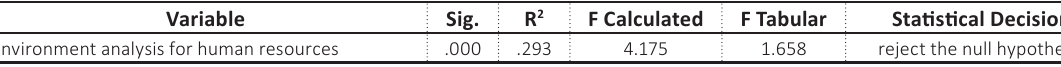
Table 8. Simple linear regression test for H2 Variable